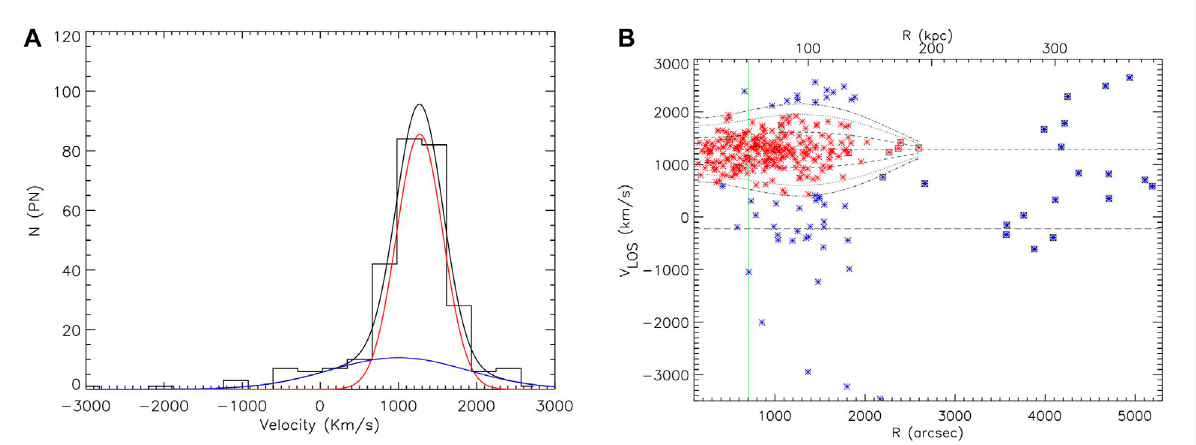
FIGURE 2 PN velocitiestracing thediffuse lightaround M87 in the Virgo cluster. (A) – Histogram of the V LOS ofthe spectroscopically con fi rmed PNe (black histogram) fi tted with a double Gaussian (black curve). Red and blue lines represent the two Gaussians associated with the M87 halo and the IC components. (B) – Projected phase-space diagram, V LOS vs. major axis distance from the centre of M87, for all spectroscopically con fi rmed PNe in Longobardi et al. (2015a). The major axis distance is given both in arcsec (bottom axis), and in kpc (top axis), where 73 pc = 1 ″ . The PNe are classi fi ed as M87 halo PNe (red asterisks) and ICPNe (blue asterisks), respectively; see text. Black squares identify spectroscopically con fi rmed PNe from Doherty et al. (2009). The smoothed 1, 2, and 2.5 σ thresholds are represented by the dashed, dotted, and dot-dashed lines, respectively. The dashed horizontal line shows the M87 systemic velocity Vsys = 1,275 kms -1 , while the continuous green vertical line shows the effective radius Re = 704 ” determined by Kormendy et al. (2009). At VLOS = − 220 kms -1 , we plot the M86 systemic velocity (long dashed line). Image reproduced from Longobardi et al. (2015a) with permission.